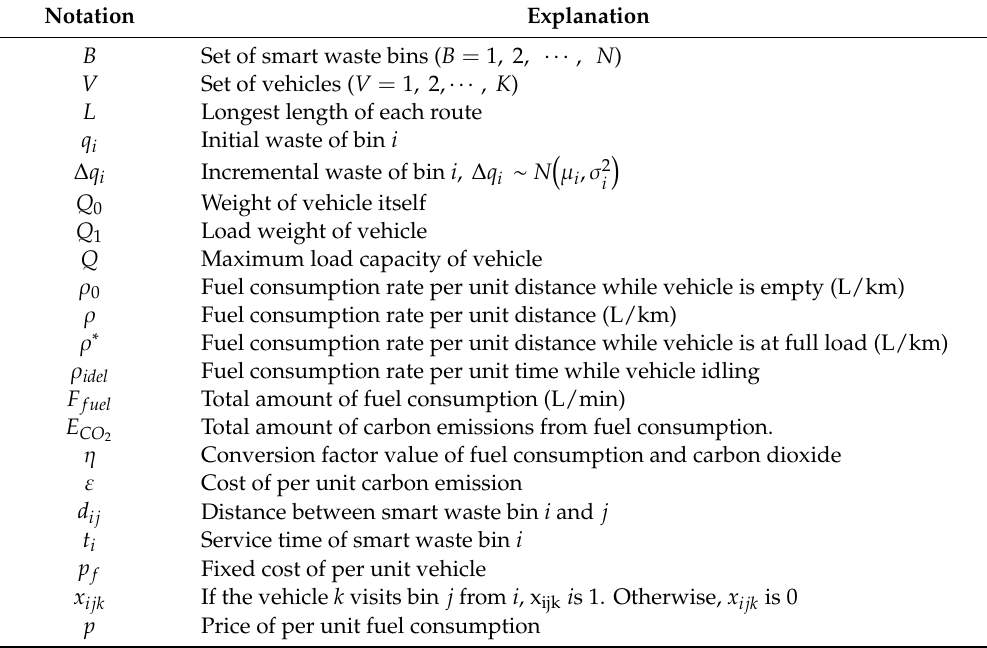
Table 1. Description of